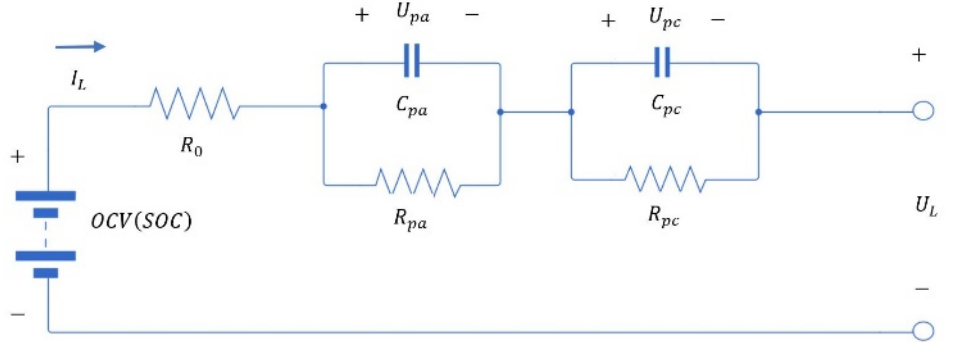
Figure 1. DP circuit diagram, as adapted from [9].